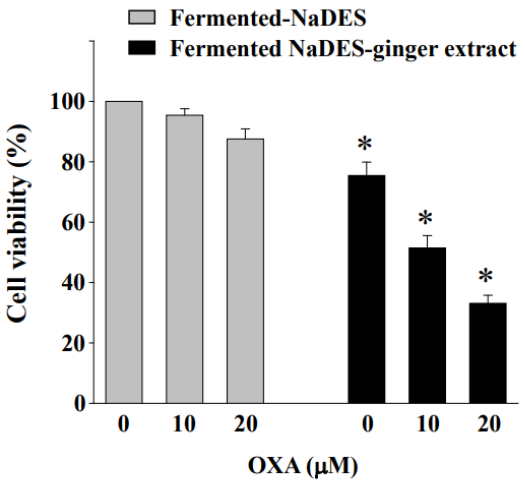
Figure 8. Fermented NaDES-ginger extract enhanced the reduction in cell viability in oxaliplatin- exposed HCT-116/R cells. HCT-116/R cells were cultured in a complete medium and then treated with fermented NaDES-ginger extract (100 µ g/mL) and oxaliplatin (10 and 20 µ M) for 24 h. After treatment, cell cytotoxicity was determined by MTT assay. The results (mean ± standard error of the mean) were from three independent experiments. * p < 0.05 vs. control cells (cells treated with fer- mented NaDES without ginger extract.